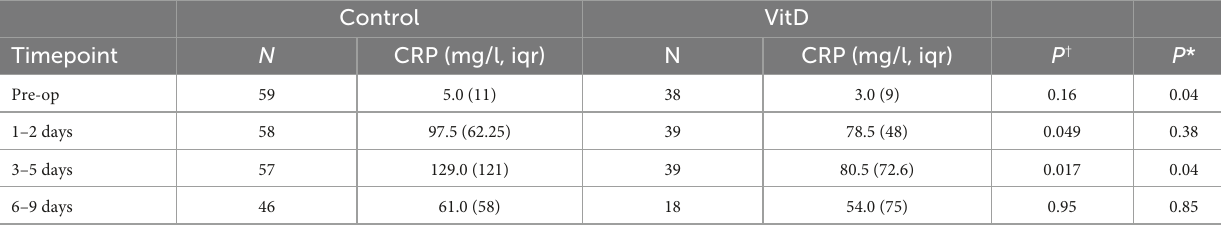
TABLE 3 Perioperative C-reactive protein (CRP) levels in control and supplemented